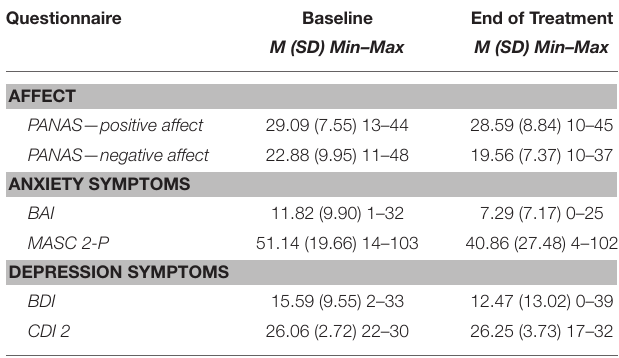
TABLE 3 | Descriptive statistics for self-report of affect, anxiety, and depression.